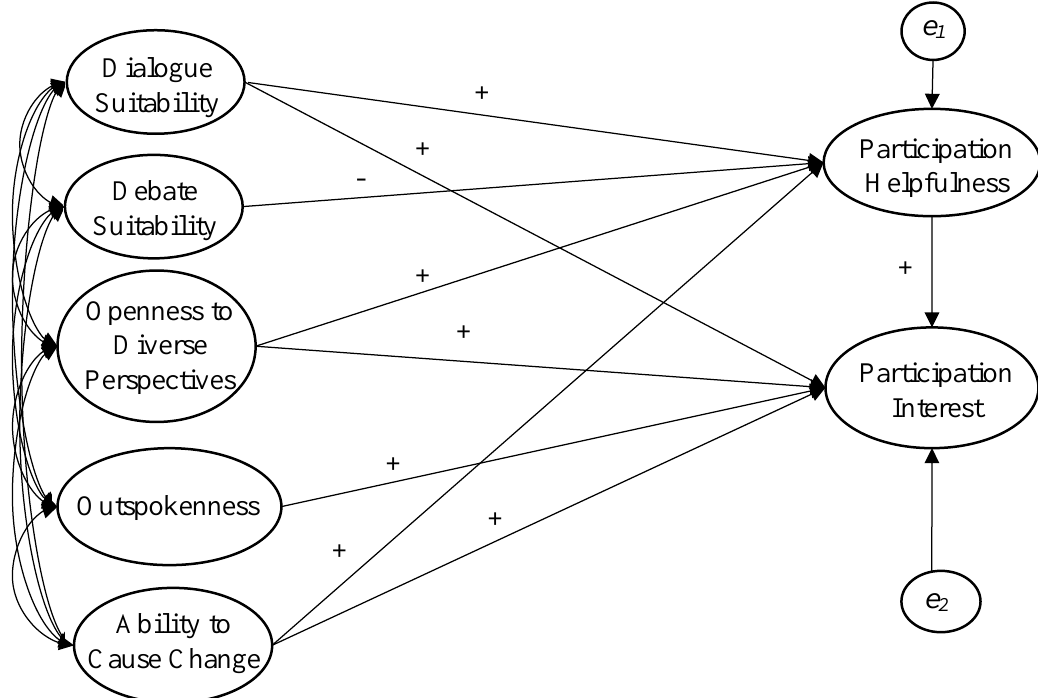
Figure 1 . Hypothesized Model of Interest in Dialogic Deliberation Participation. Positive relationships denoted by + sign; negative relationships denoted by -